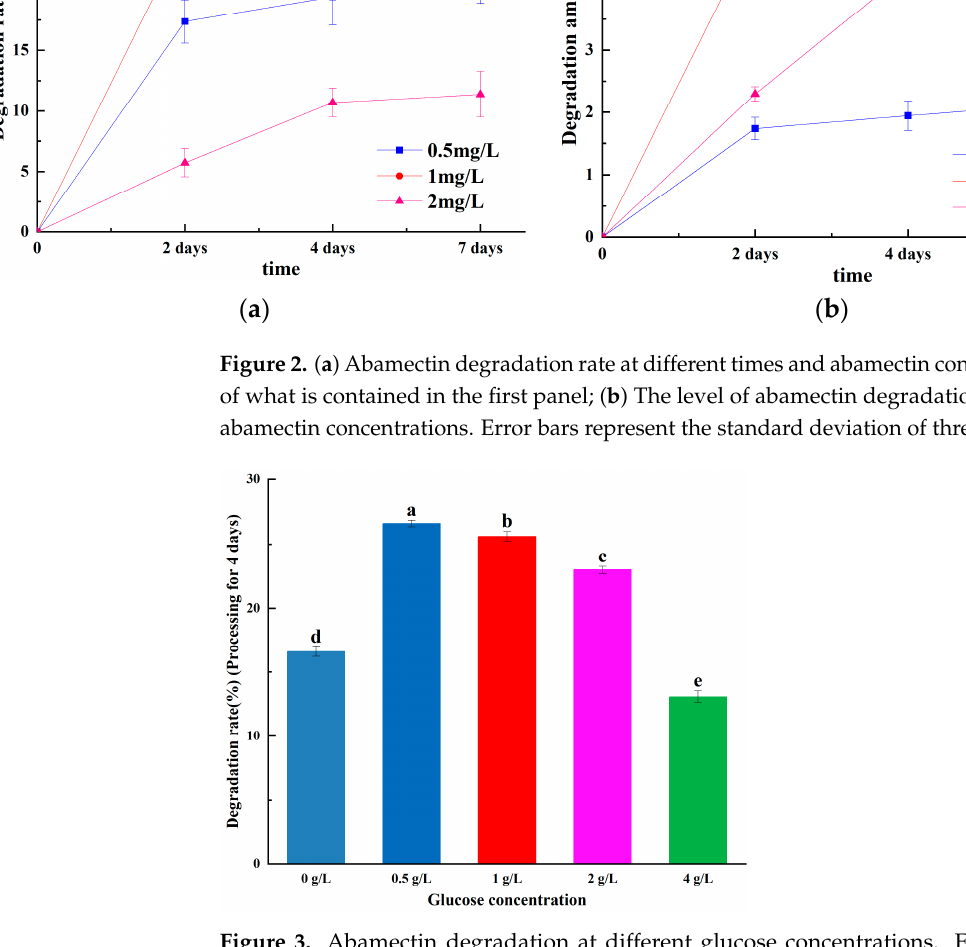
Figure 3. Abamectin degradation at different glucose concentrations. Error bars represent the stand- ard deviation of three replicate experiments, and different letters indicate significant differences as determined by Waller-Duncan’s test ( P < 0.05).